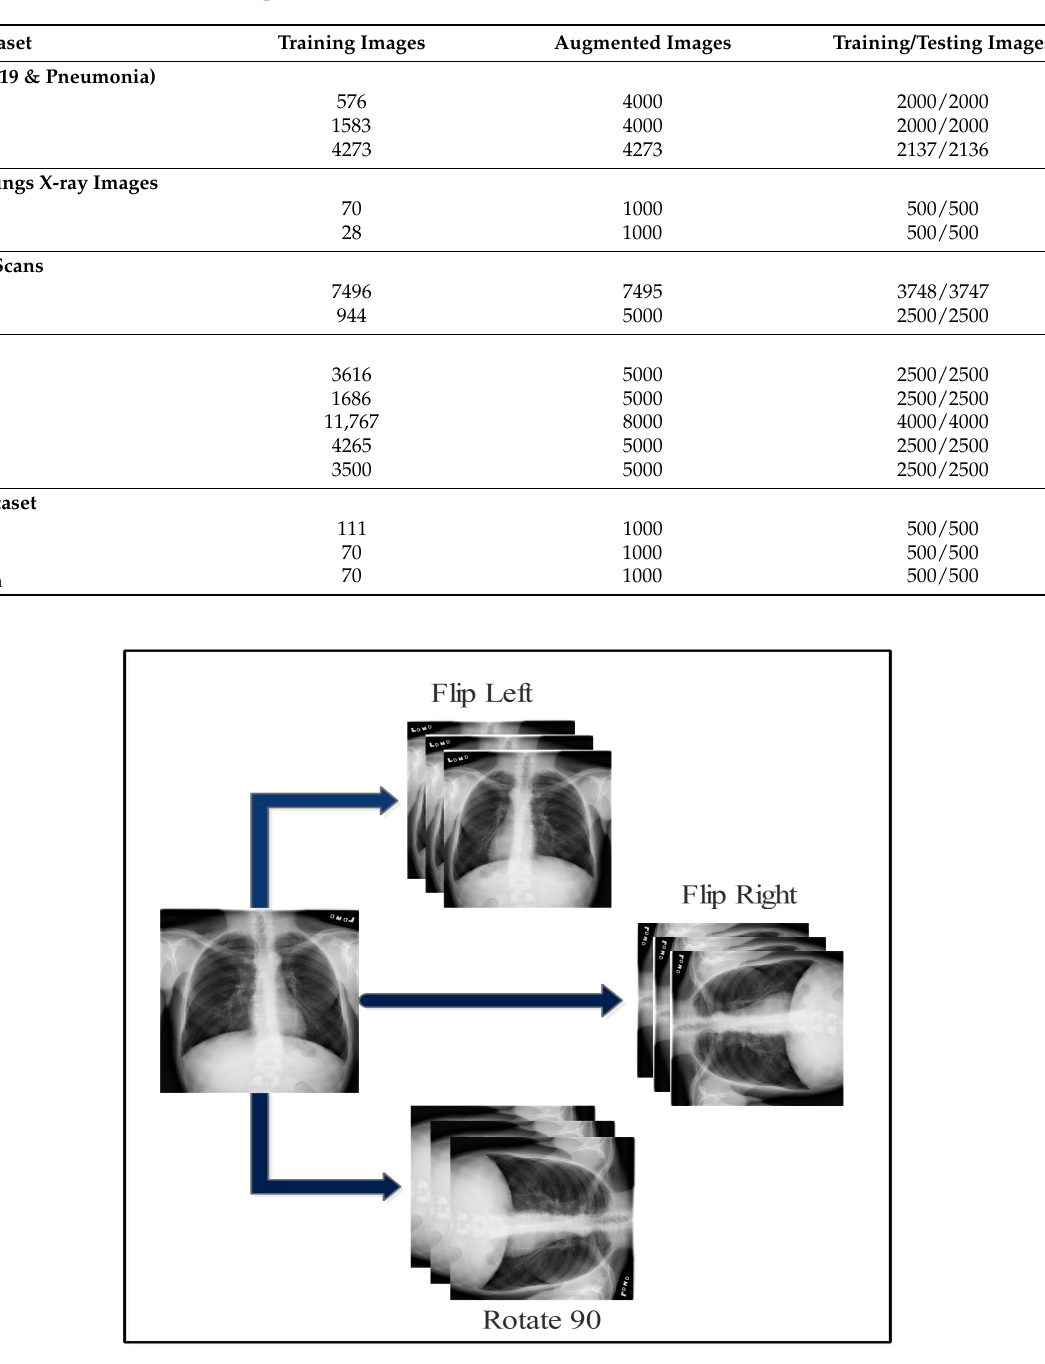
Table 1. Description of five different COVID-19 datasets.